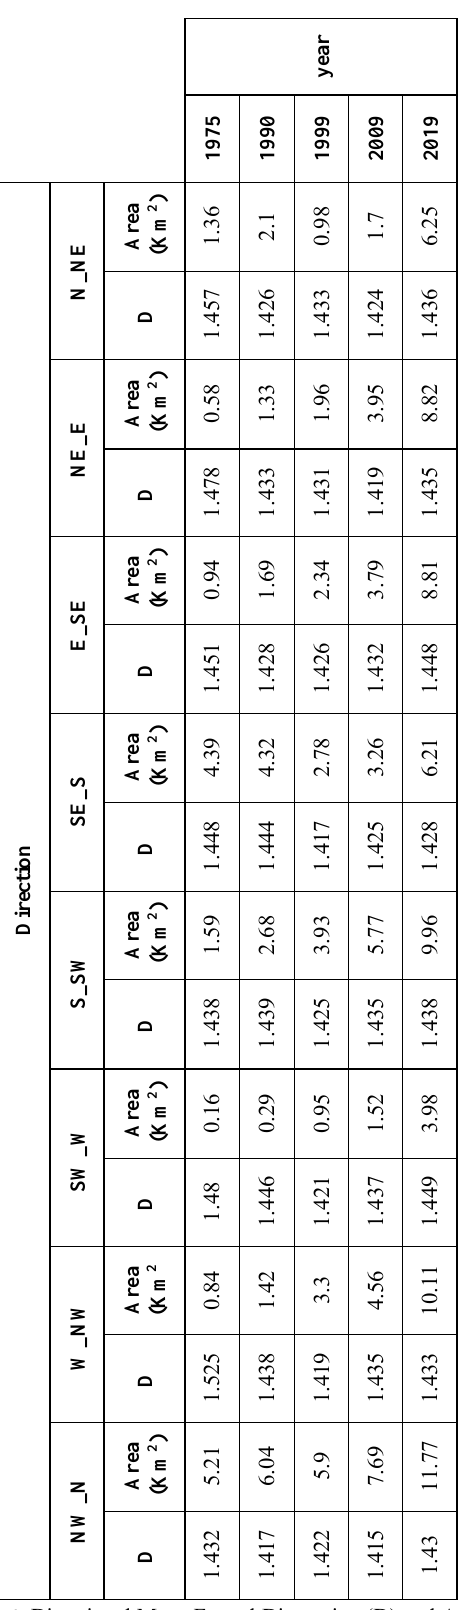
Table 4. Directional Mean Fractal Dimension (D) and Area of Vasai